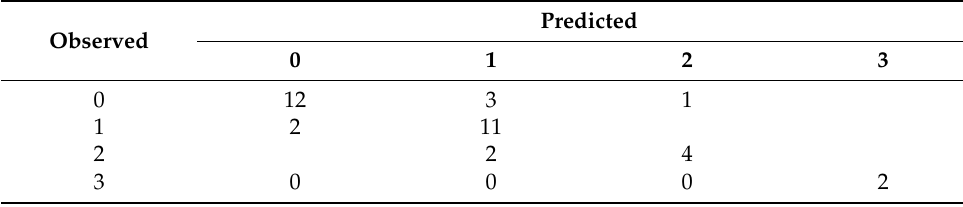
Table 4. Confusion matrix of the severity of insect infestation.